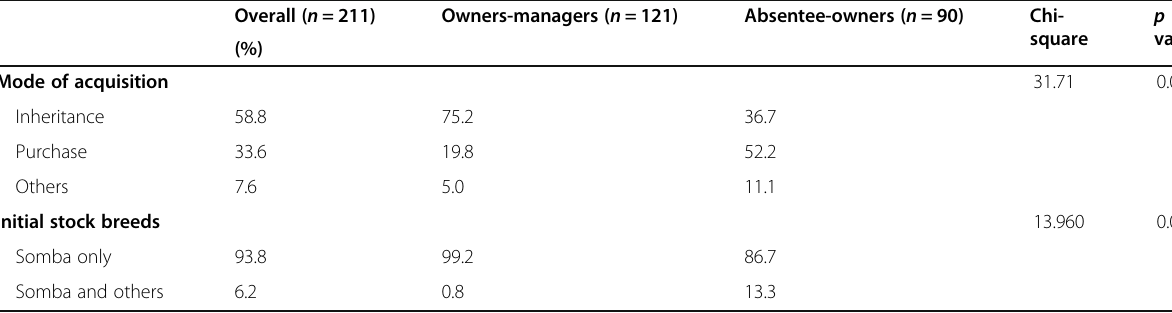
Table 4 Initial stock breeds and mode of acquisition by cattle owner-herders and